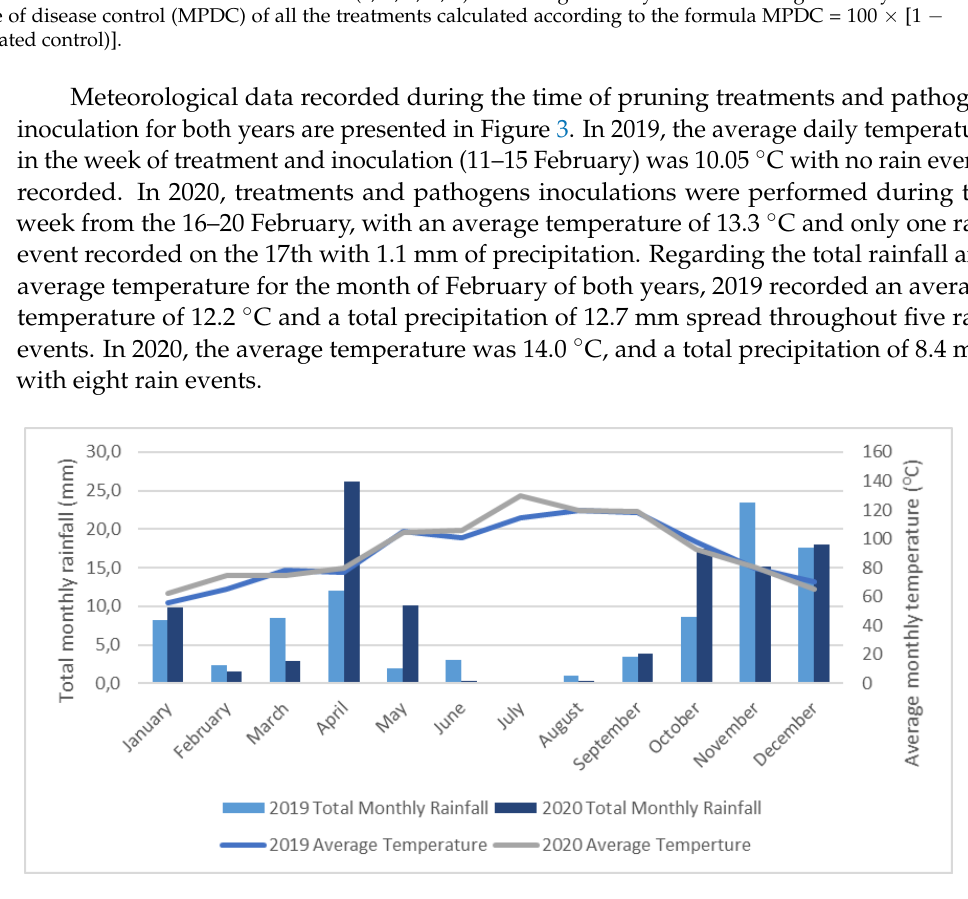
Figure 3. Monthly rainfall and average temperature for the two years of the trial. The principal component analysis (PCA) was performed to better visualize the rela- tionship between all the variables (Figure 4A,B). For 2019 (Figure 4A), the two first principal components, accounted for 59.9% of the total variability of the data (PC1—41.78%; PC2— 18.12%), while for 2020 (Figure 4B) the two first principal components represented 53.98% of the total variability of the data (PC1—35.34%; PC2—18.64%). For both years, we could also observe a clear distribution of the RP of the treatments according to the cultivar, which probably results from the influence of the different susceptibility that both cultivars may have towards the different pathogens studied. The relationship between the treatments and the meteorological variables could be observed in the vector plots of Figure 4A,B. For both years, meteorological variables showed similar behavior with precipitation being more related to component 1, while temperature showed a higher relation with component 2. In the vector plots, it was observed that the two meteorological variables were very weakly correlated, especially in 2020, where almost no correlation occurred between the